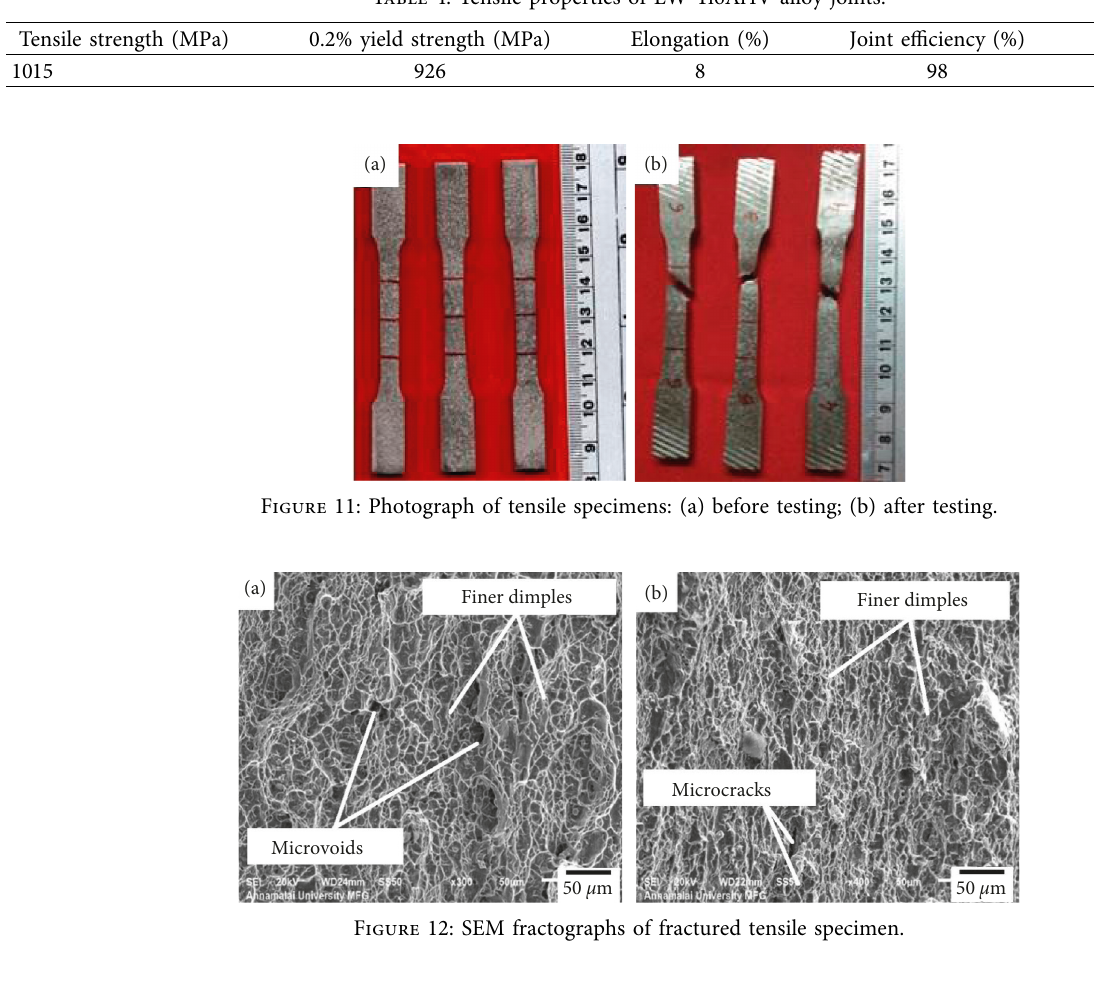
Table 4: Tensile properties of LW-Ti6Al4V alloy joints.